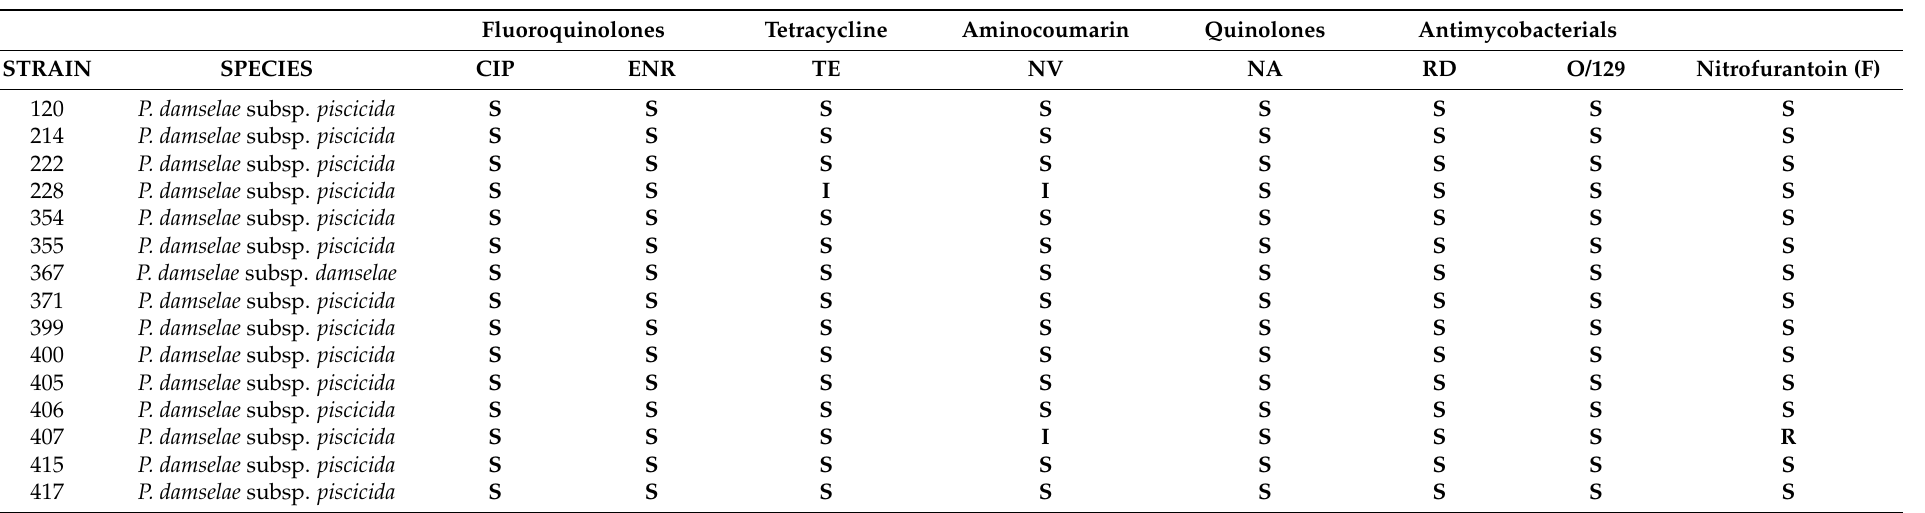
Table 4. List of the strains and the antibiotics used for the antibiograms (CIP: ciprofloxacin, ENR: enrofloxacin, TE: tetracycline, NV: novobiocin, NA: nalidixic acid, RD: rifampicin, 0/129: vibriostatic). The results are depicted by R: resistant, S: susceptible, and I: